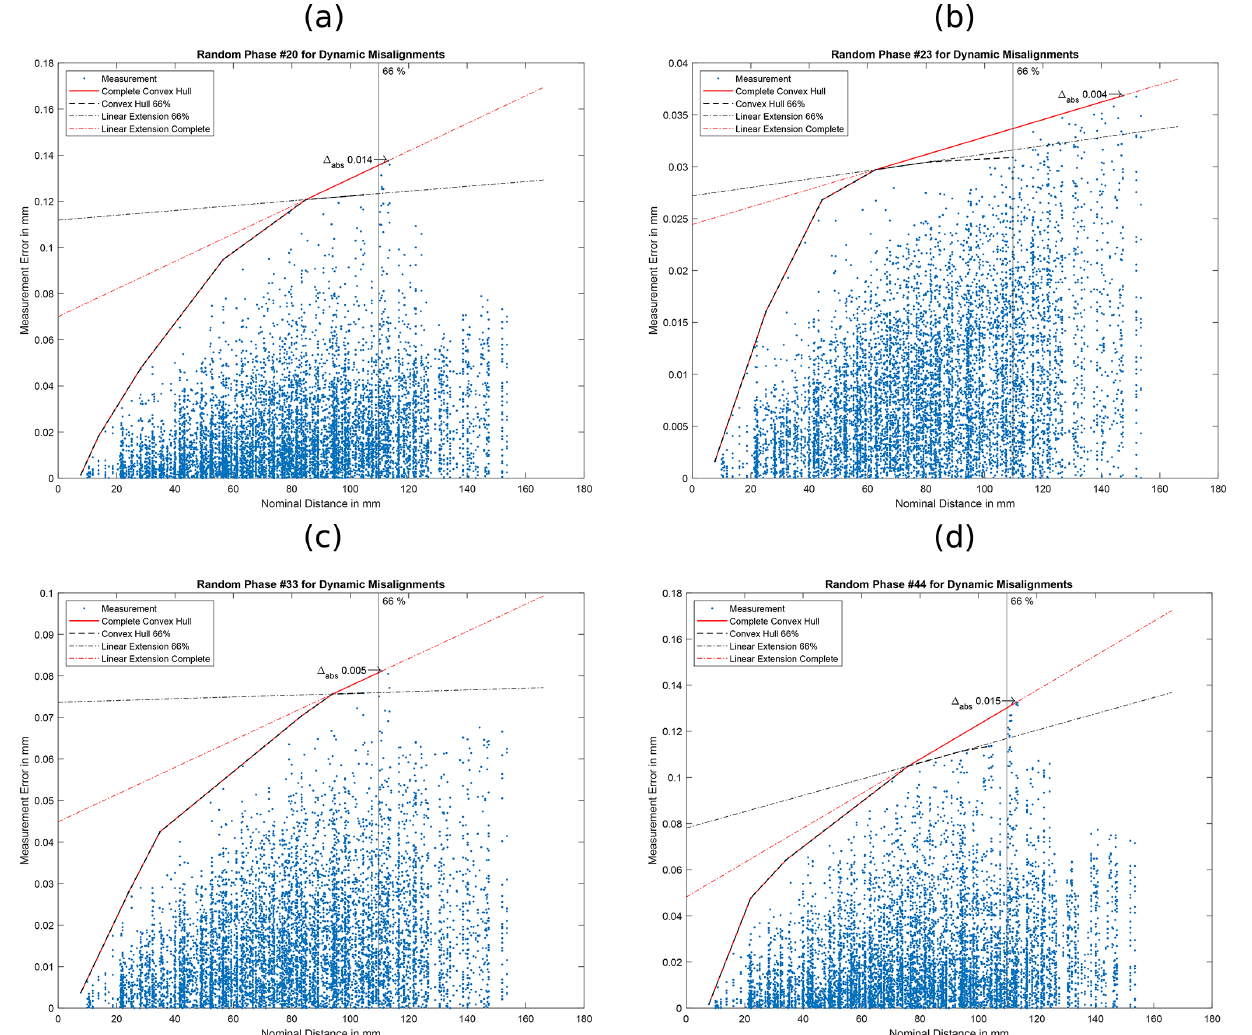
Figure 11. Convex hull analysis of non-linearity: the plots show the data points, both convex hulls (using points until 66% and using all points) as well as derived MPE specifications. The (cid:49) abs marks the data point with the largest distance to the 66% MPE specification. The plots are for four of the five simulations with random phase angles from Sect. 4.3 and part of simulation set II (for the last one, see Fig.